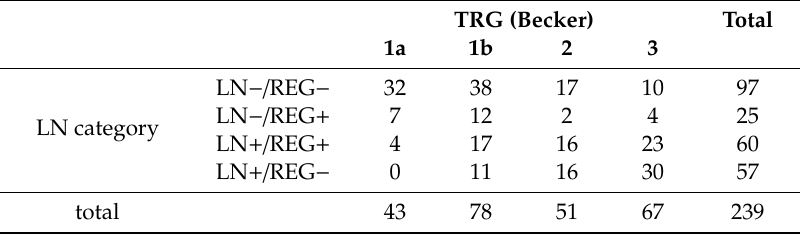
Table 2. Lymph node (LN) categories and Tumor Regression Grades of the primary